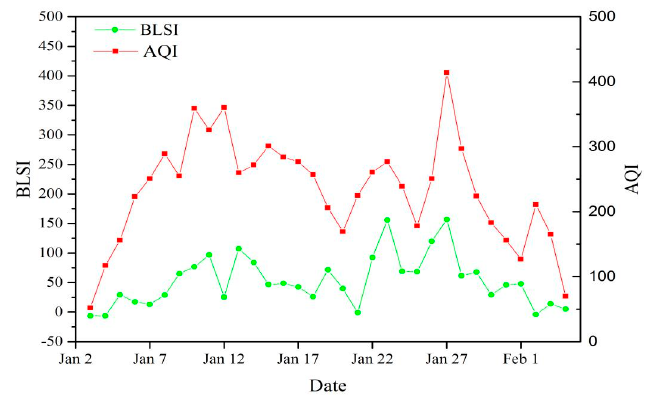
Figure 8. Changes of sequence of BLSI at 300 m (green line, multiply by 10 6 ) and AQI (red line) with time during a seriously polluted period (3 January 2013–4 February 2013).